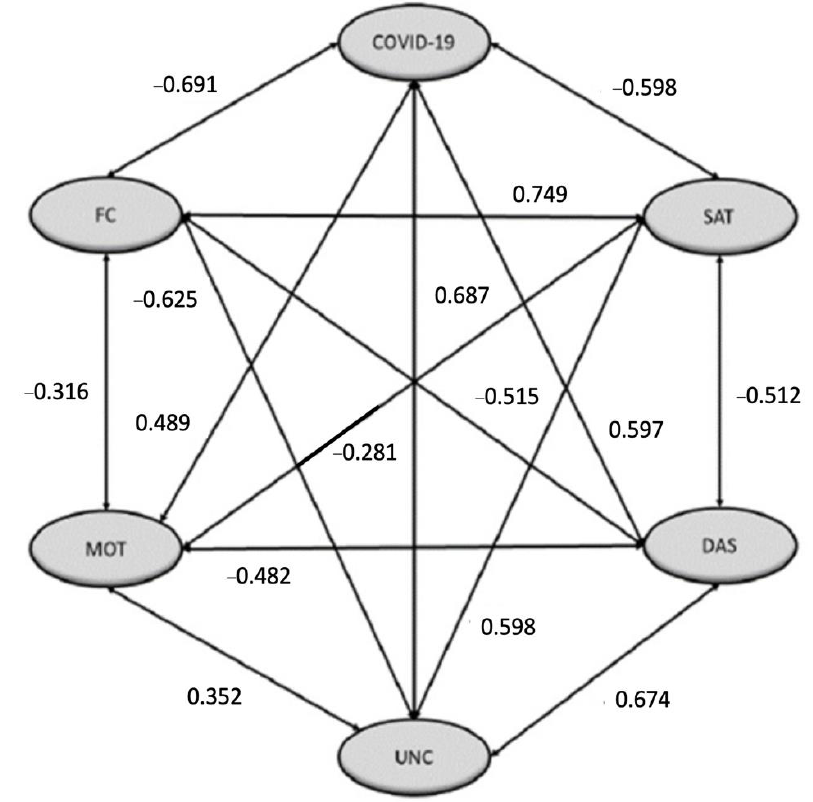
Figure 2. Estimations of the structural equation model. The relations were significant at p < 0.001. Note: Own production.